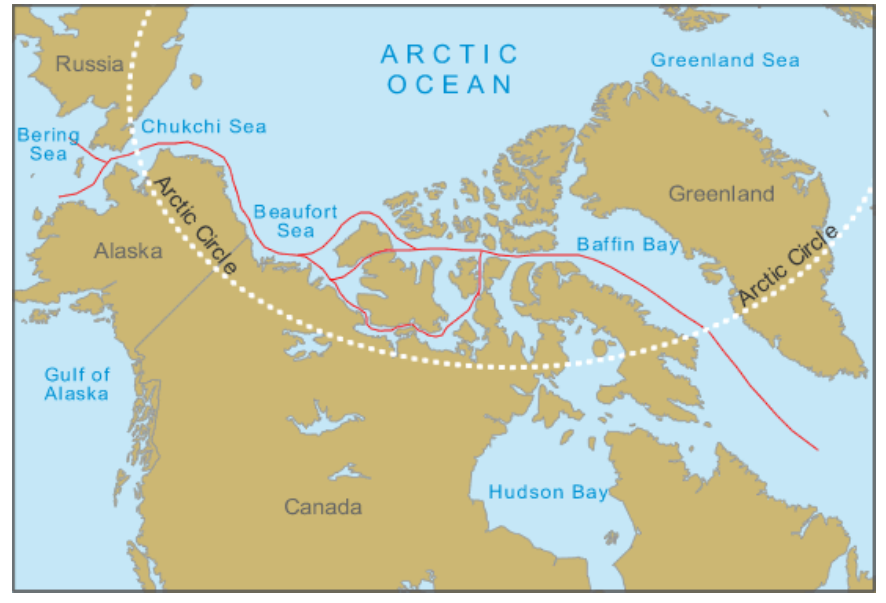
Figure 8. Northwest Passage: red lines are possible ship routes (source: [30], where this figure is directly cited without copyright issue).